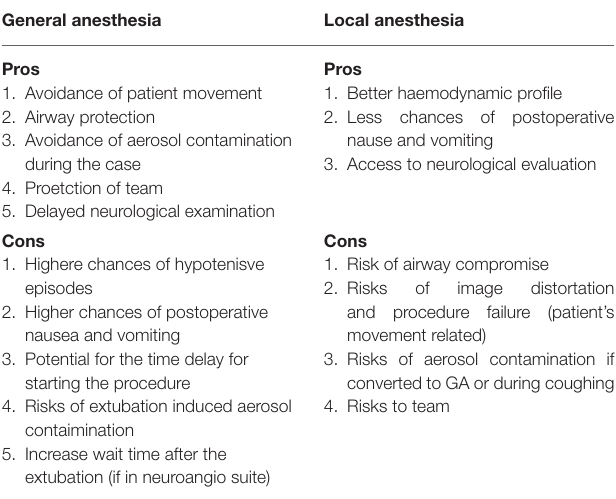
TABLE 1 | Pros and cons of general anesthesia and monitored anesthesia care in COVID-19 patient undergoing mechanical thrombectomy for ischemic stroke. General